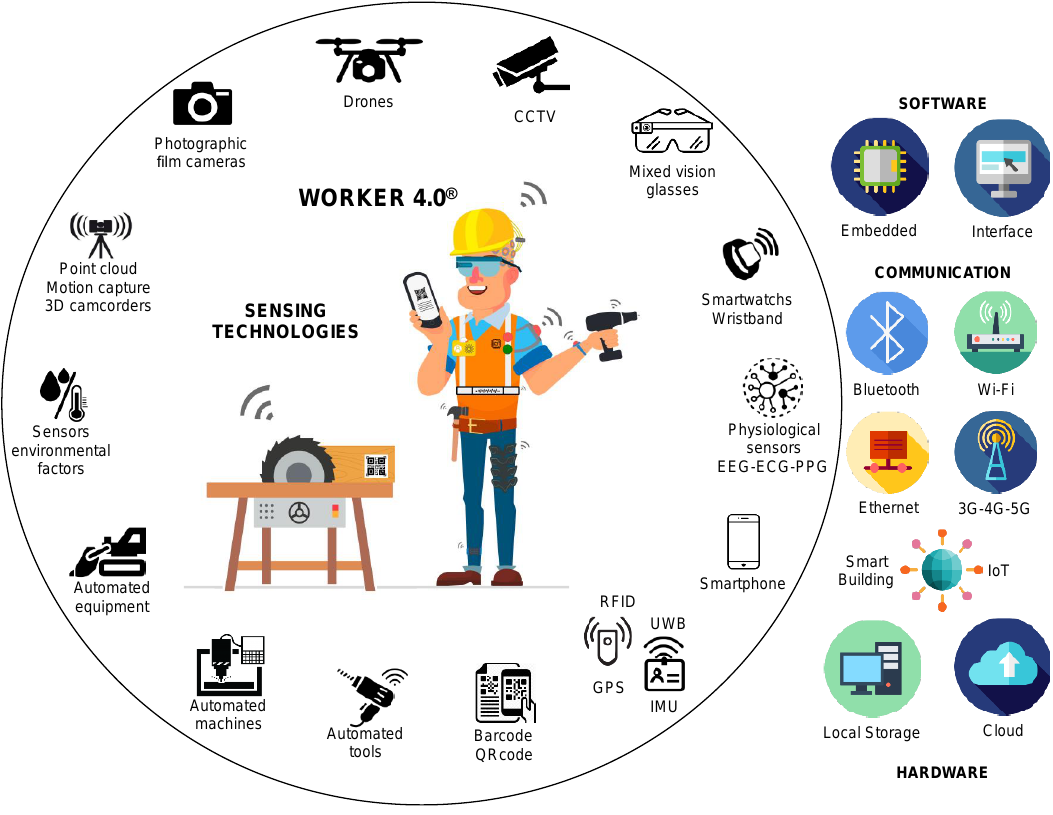
Figure 2. Worker 4.0: Sensored construction sites.